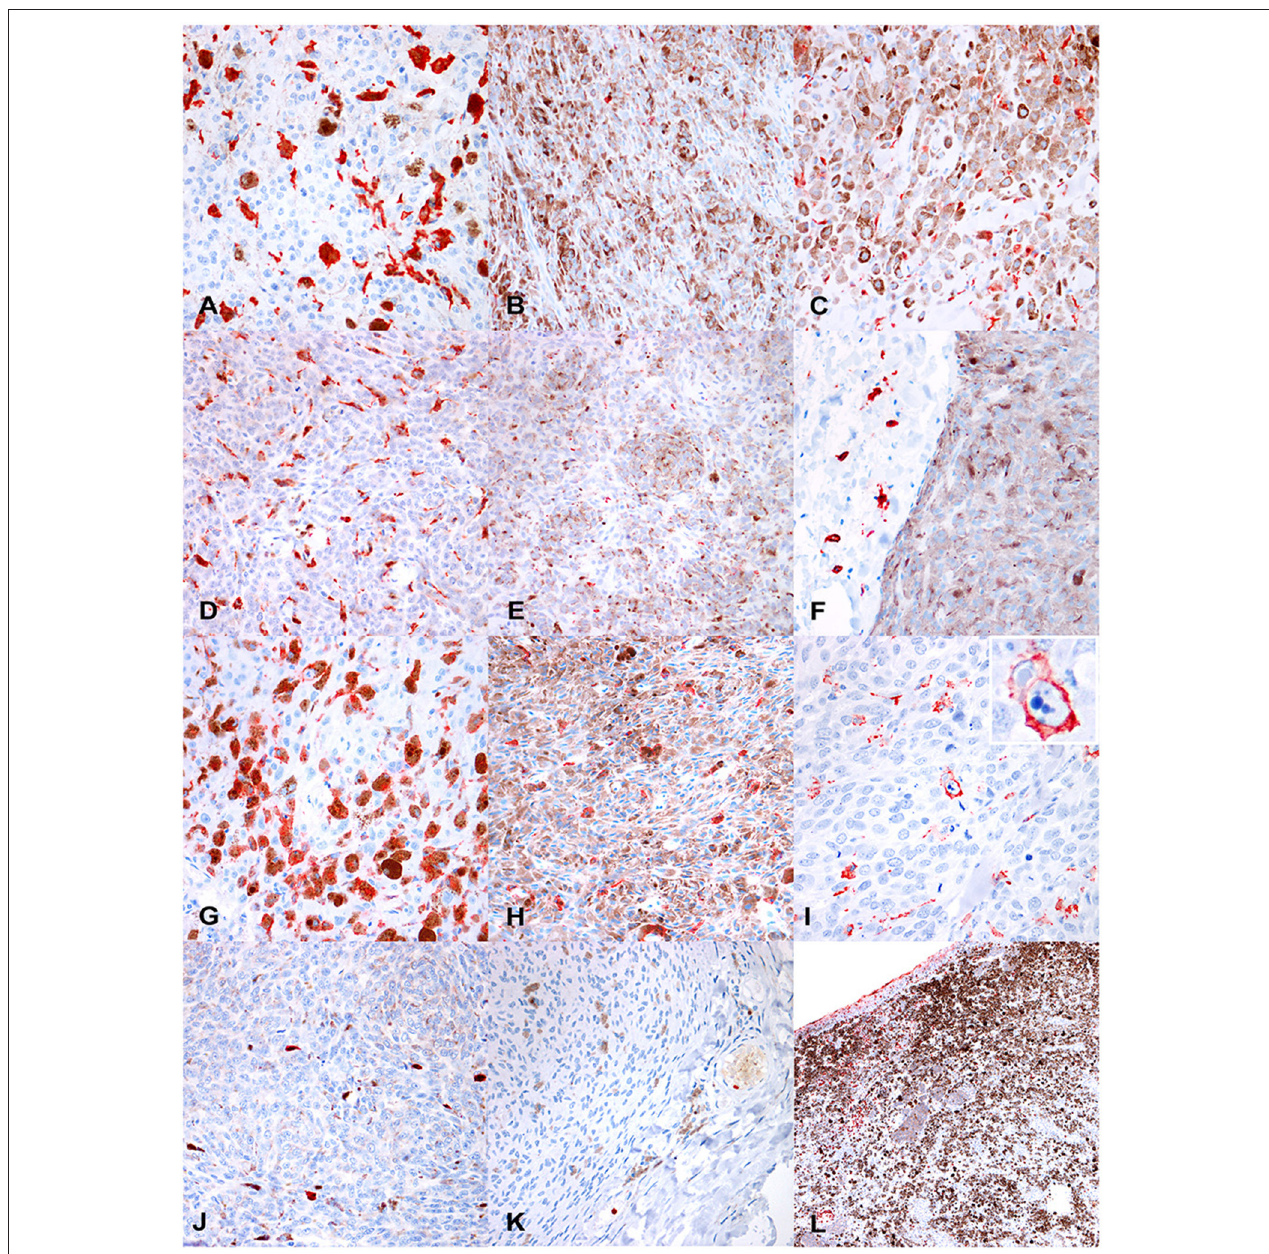
FIGURE 3 | (A) Canine, cutaneous melanoma. Numerous intratumoral, large, Iba1 + cells. Non neoplastic cells containing melanine (melanophages) are often faintly positive or negative (400 × , AEC and hematoxylin). (B) Canine cutaneous melanocytoma. Rare intratumoral IBA1 + cells (400 × , AEC and hematoxylin). (C) Canine cutaneous melanocytoma. In some tumors, Iba1 + cells were smaller and with a more spindloid shape (400 × , AEC and hematoxylin). Immunohistochemical results. (D) Canine, oral melanoma. Disseminated intratumoral CD163 + cells, that show a polygonal-to-spindloid morphology (400 × , AEC and hematoxylin). (E) Canine, cutaneous melanocytoma. Scattered CD163 + cells (400 × , AEC and hematoxylin). (F) Canine, cutaneous melanocytoma. Extratumoral CD163 + cells, not infiltrating the tumor (400 × , AEC and hematoxylin). (G) Canine, oral melanoma. Numerous, disseminated, intratumoral CD204 + cells, that show a variable morphology, from rounded to elongated (400 × , AEC and hematoxylin). (H) Canine, oral melanocytoma. Scattered CD204 + cells among neoplastic cells. (I) Canine, cutaneous melanoma. Occasionally, CD204 + cells, showed phagocytic activity (detail in the inset; 400 × , AEC and hematoxylin). (J) Canine, oral melanoma. Occasional MAC387 + cells, in deeper areas of the tumor far from areas of ulceration (400 × , AEC and hematoxylin). (K) Canine, cutaneous melanocytoma. Occasional intravascular MAC387 + cells, likely migrating into the tissue, whereas no MAC387 + cells can be seen into the tumor (400 × , AEC and hematoxylin). (L) Canine, oral melanoma. Numerous MAC387 + cells (both macrophages and neutrophils) are present near superficial ulceration (200 × , AEC and hematoxylin).